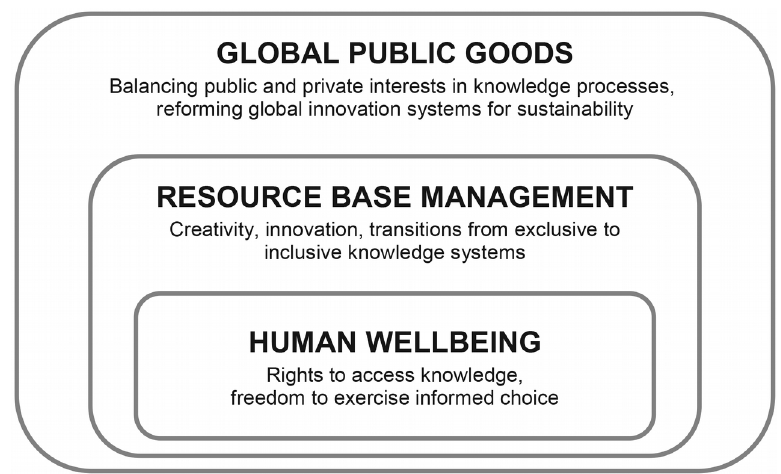
Figure 2. Knowledge governance for sustainable development—a framework for future